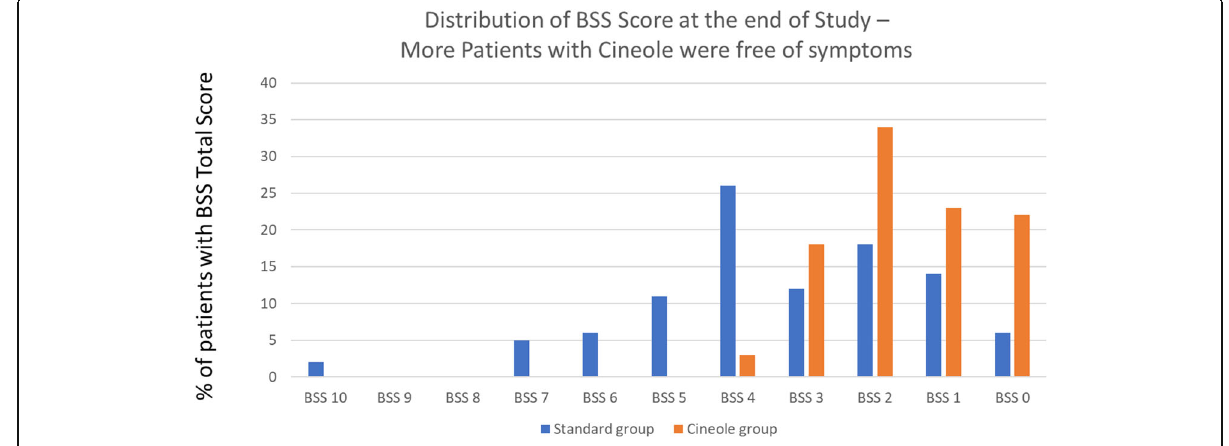
Fig. 4 Distribution of BSS at the final visit (Standard group: standard antiviral only; Cineole group: standard antiviral +